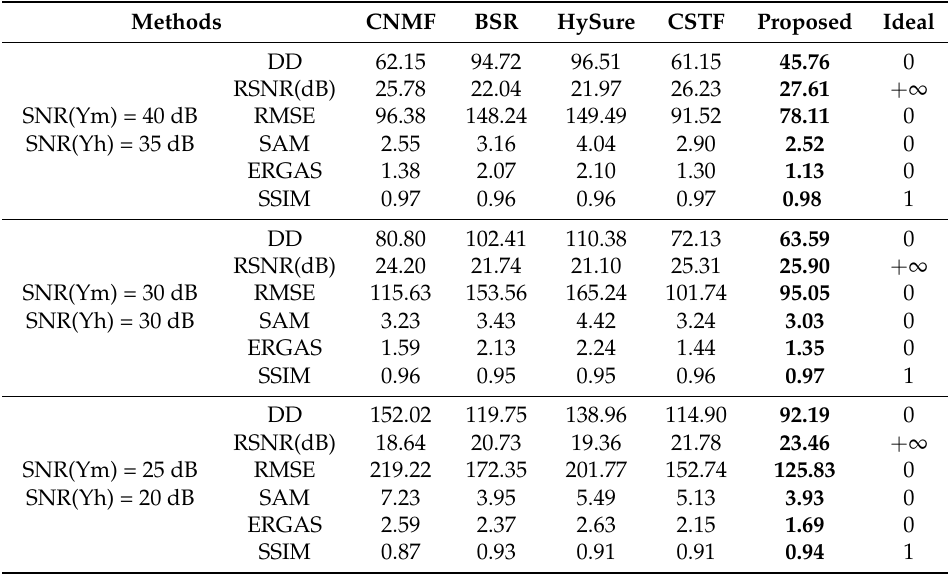
Table 2. Performance comparison of fusion algorithms for Pavia University dataset (the boldface numbers denote the best